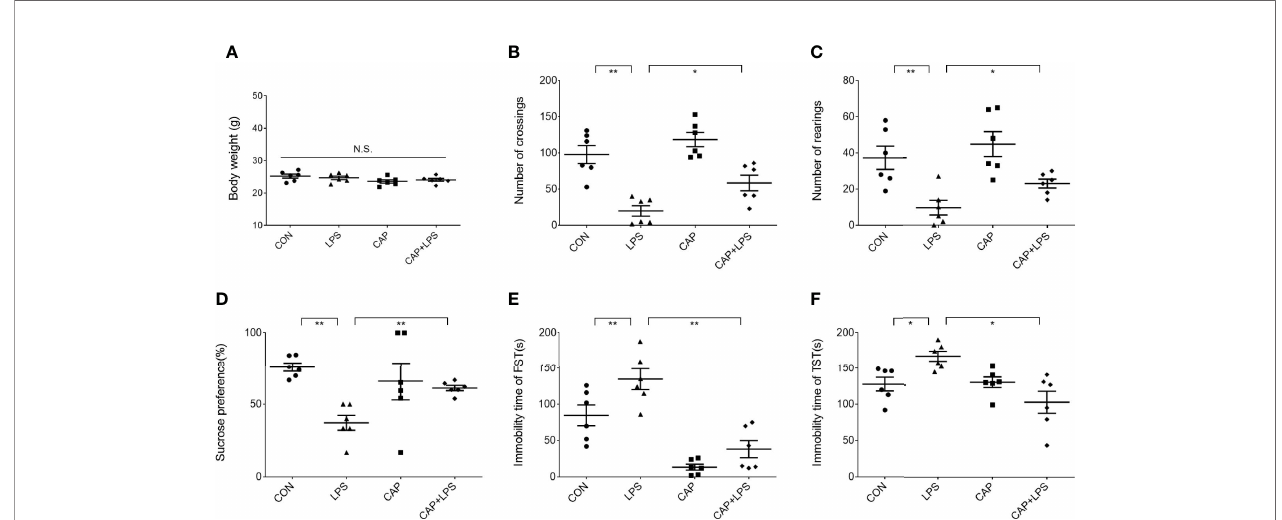
FIGURE 2 | Effects of dietary CAP on body weight and depression-like behavior in LPS-treated mice. (A) Body weight (F 3,20 = 1.771, P > 0.05). (B) Number of crossings in open fi eld test (F 3,20 = 17.99, P < 0.01). (C) Number of rearings in open fi eld test (F 3,20 = 8.728, P < 0.01). (D) Sucrose preference of sucrose preference test (F 3,20 = 5.296, P < 0.01). (E) Immobility time of forced swimming test (F 3,20 = 20.05, P < 0.01). (F) Immobility time of tail suspension test (F 3,20 = 6.411, P < 0.01). Results are represented as mean ± SEM (n = 6). Asterisk has been used for signi fi cant differences (*P < 0.05, **P < 0.01, N.S., not signi fi